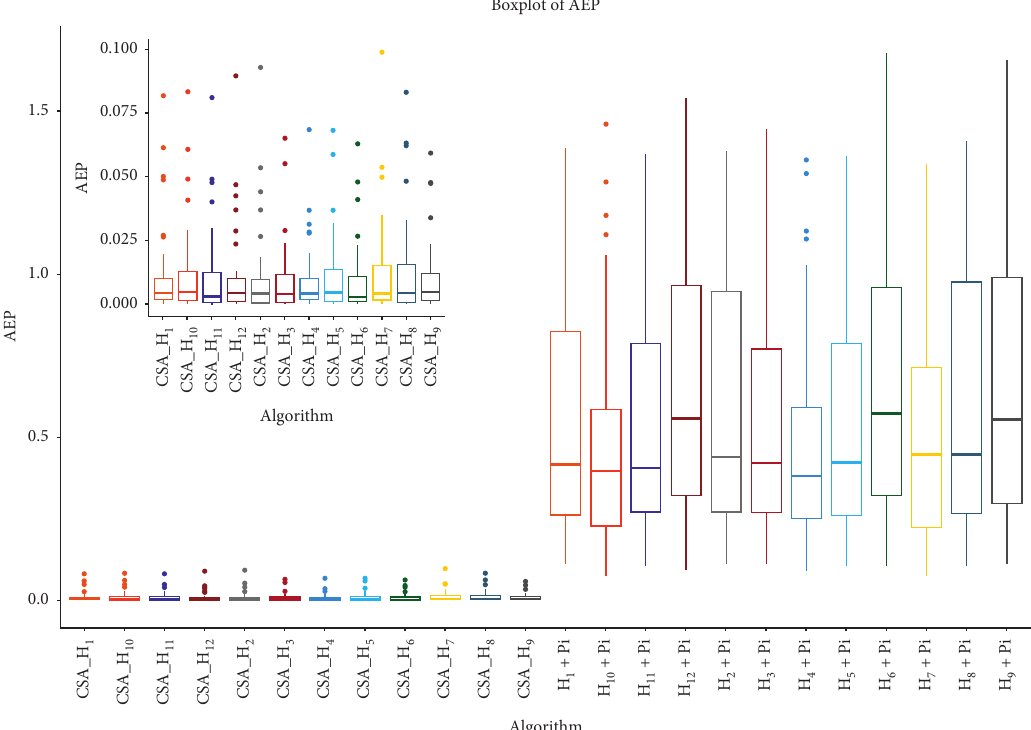
Figure 4: The boxplots of 12 heuristics and 12 CSA-Hs algorithms (small n